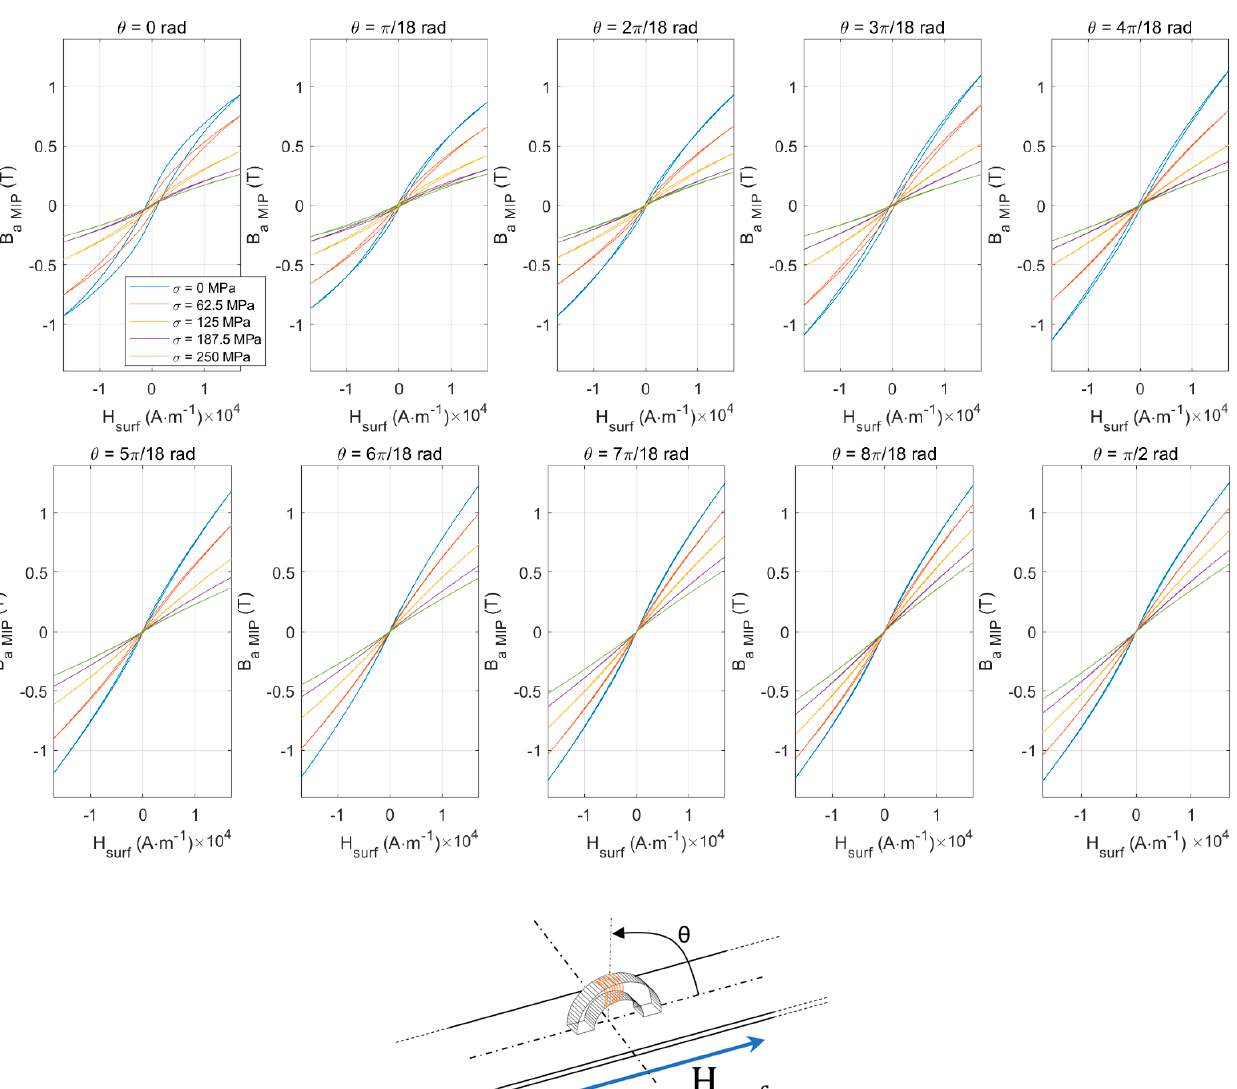
Figure 13. B a MIP ( H surf ) hysteresis cycles in the [0– π /2] angle range.